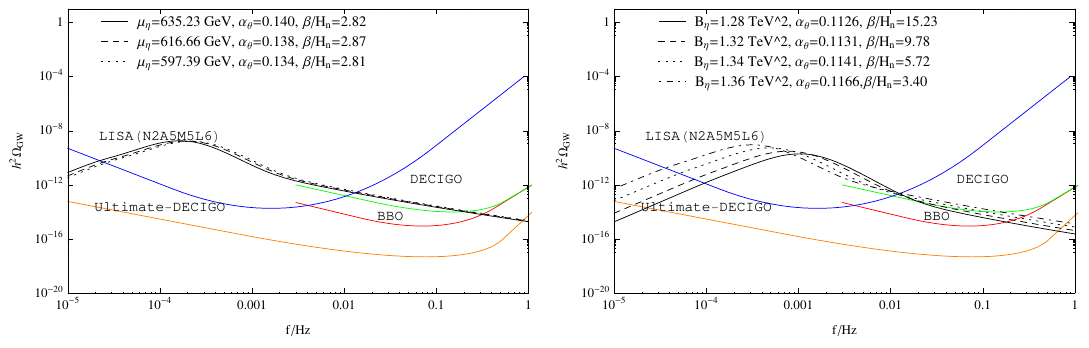
Figure 9 . The contributions of GW spectrum vary with parameters µ η and B η in the B-LSSM. After fixing tb = 20, g Y B = 0 . 15, g B = 0 . 5, m η = 1 . 6 TeV and m ¯ η = 300 GeV −